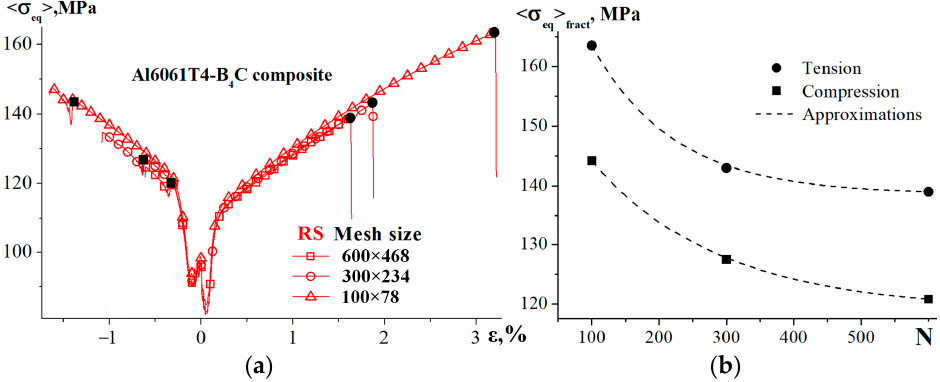
Figure 5. Mesh dependent final patterns of equivalent plastic strain in the Al6061T4 matrix and fractured regions in the B 4 C particle under tension or compression of the composite in the RS case.